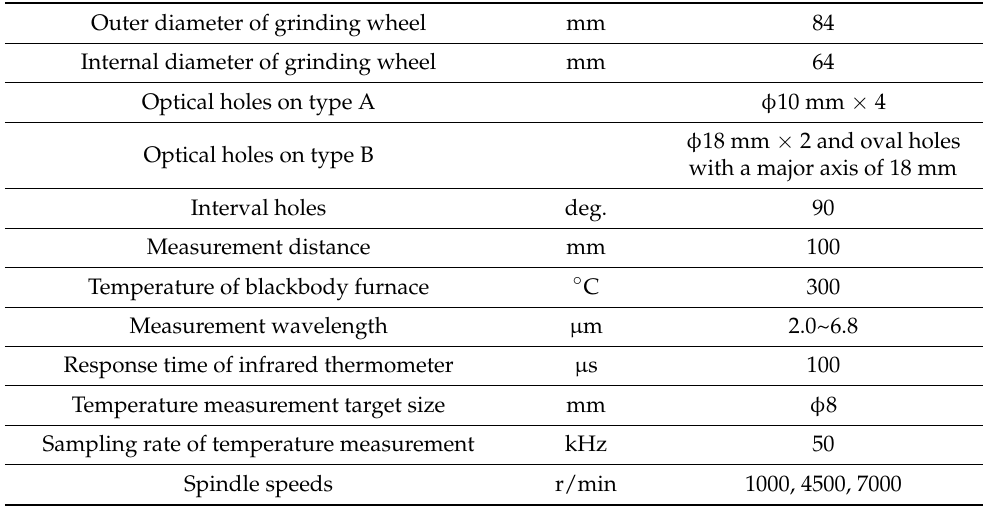
Table 2. Experimental conditions for measuring temperature on blackbody